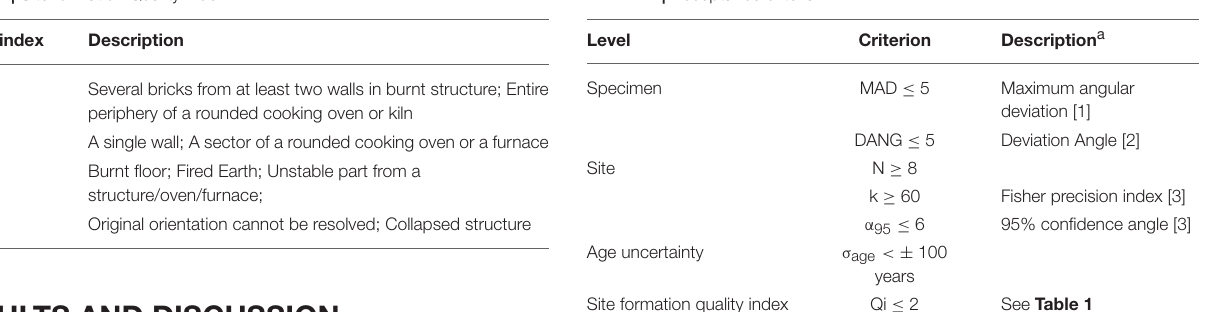
TABLE 1 | Site formation Quality Index. TABLE 2 | Acceptance